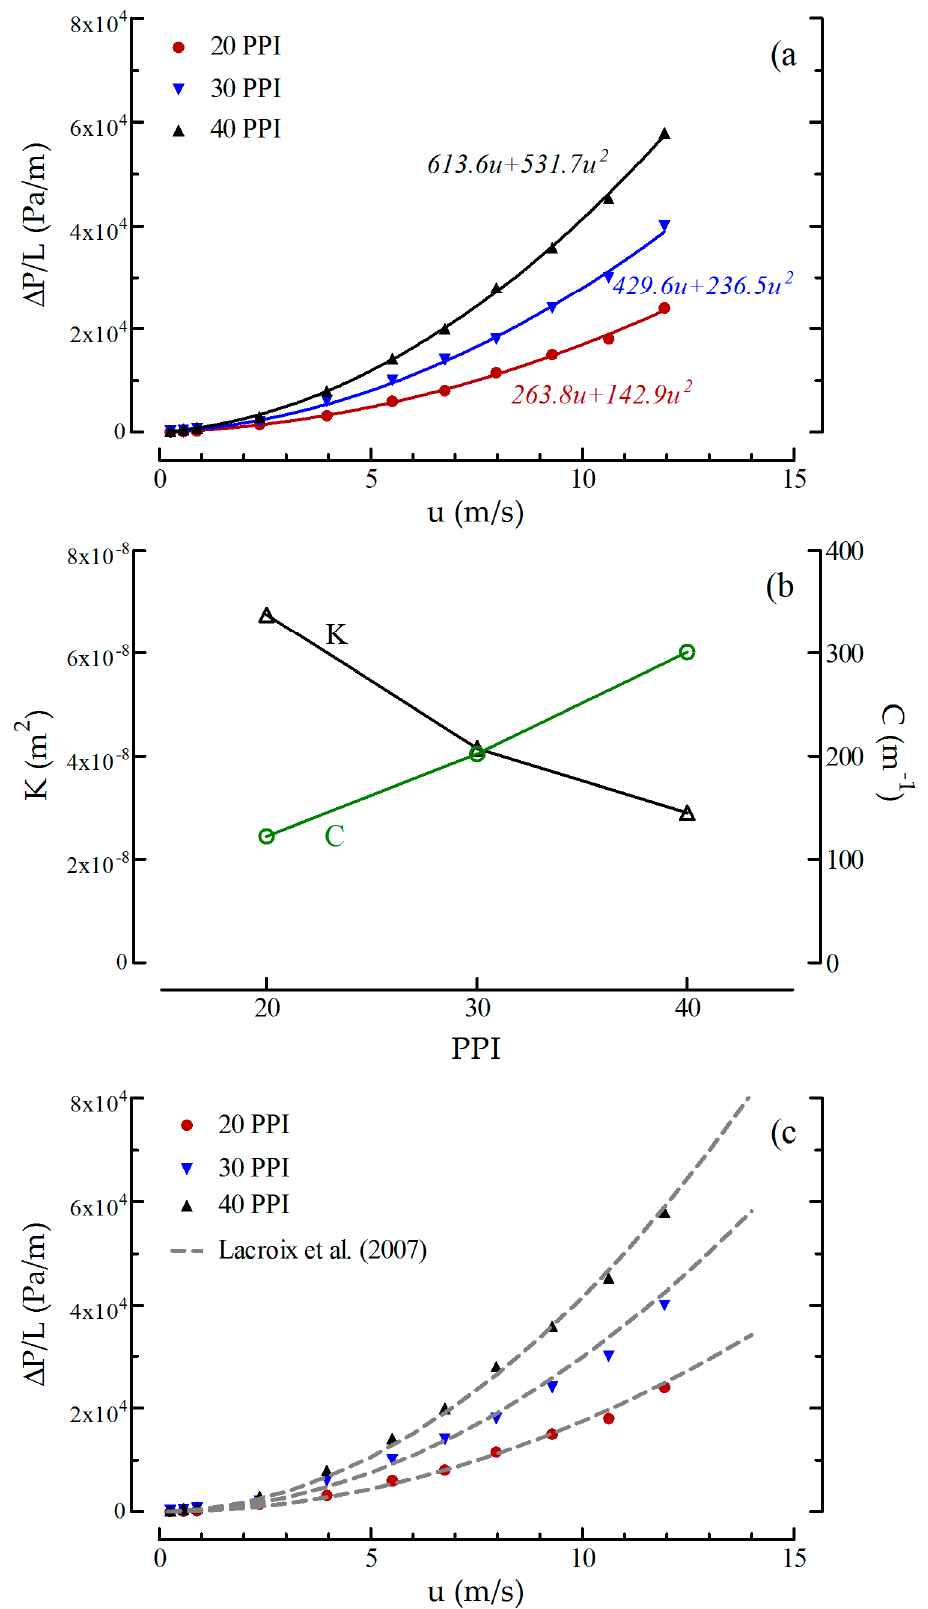
Figure 2. Pressure drop measurements for different foam density: Forchheimer-extended Darcy theoretical estimation ( a ); effect of pore density on the permeability and form coefficient ( b ); Lacroix-extended Ergun theoretical estimation ( c